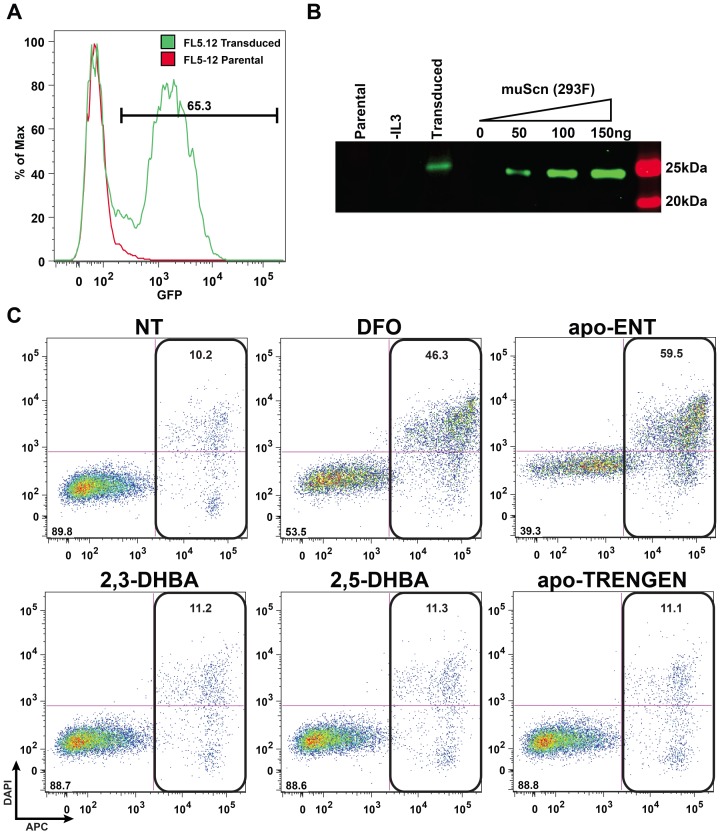
Stably-induced expression of Scn does not drive apoptosis in FL5.12 cells.(A) FL5.12 cells were transduced with the pCVL-SFFV-muScn-IRES-GFP lentivirus and GFP mean fluorescence intensity was determined one-week post-transduction by cytometry, confirming transgene functionality. (B) A Western blot of supernatants, concentrated from 32 µL, from FL5.12 cells shows that the transduced cells constitutively express Scn, while parental cells in the presence or absence of IL-3 do not secrete detectable amounts of Scn after 72 h in culture. (C) Transduced FL5.12 were incubated with a variety of siderophores in order to assess the role of exogenous siderophores on cell viability (NT: no treatment). The hexadentate chelators DFO and Ent at 100 µM produce robust apoptosis, while the bidentate chelators at 300 µM do not affect viability.